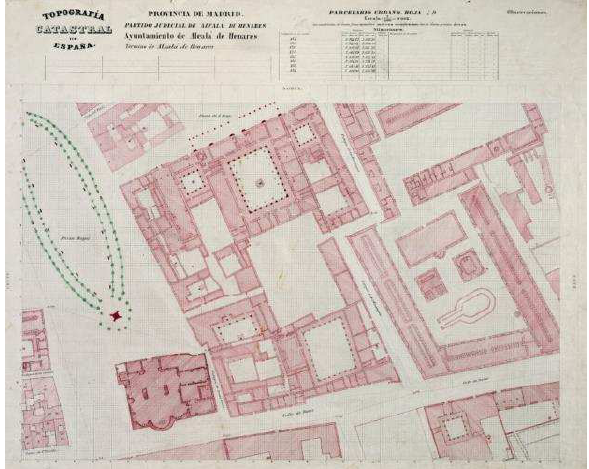
Figure 3: Kilometric sheets. 1/500 from Servicio Geográfico Nacional. 1870. Sheets D4.